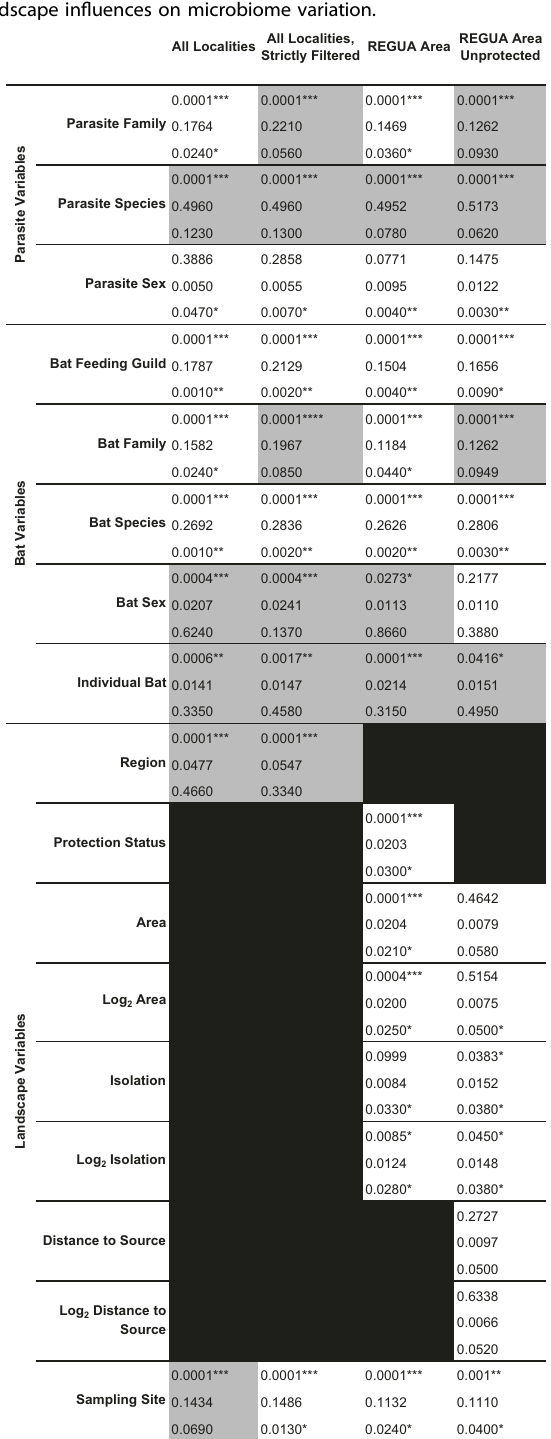
Bacterial association networks The connectance and betweenness centrality of habitat patch networks varied with habitat patch effects, but modularity did not (Figs. 4 and 5). Network connectance was signi fi cantly lower in REGUA patches than in networks constructed for sites outside of REGUA (Fig. 5B; Wilcoxon Rank Sum test, p value = 0.012). Betweenness centrality was higher in networks for patch F4, F2, and F1 (i.e., smallest patches), corresponding with their band-like network structure (Fig. 4), and centrality was signi fi cantly different